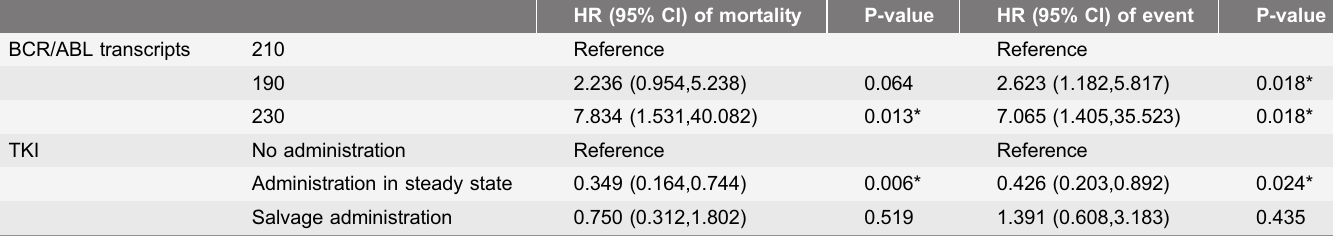
Table 4. Multivariate Analyses: Contributing Factors for Mortality and Event